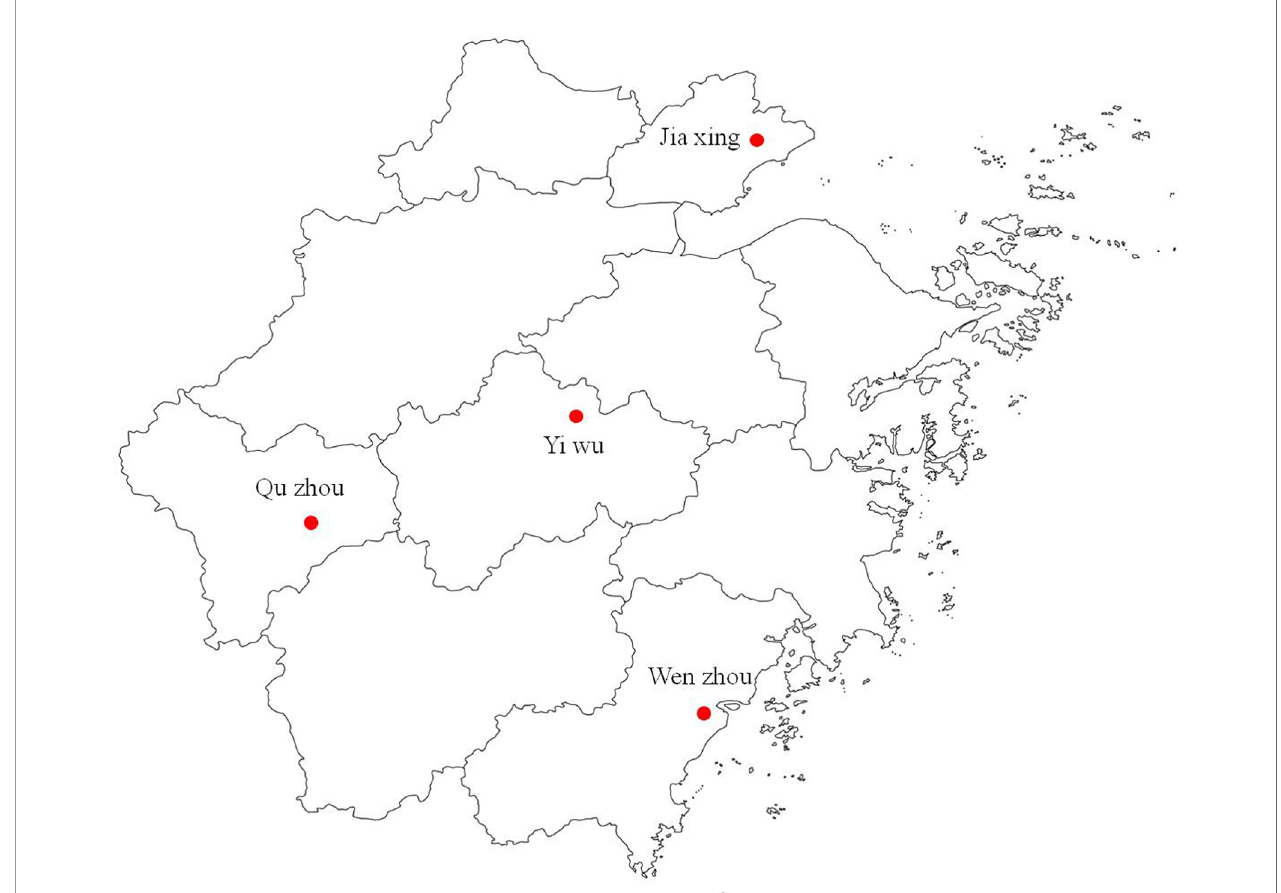
FIGURE 1 | Map of Zhejiang Province showing the Ae. albopictus collection